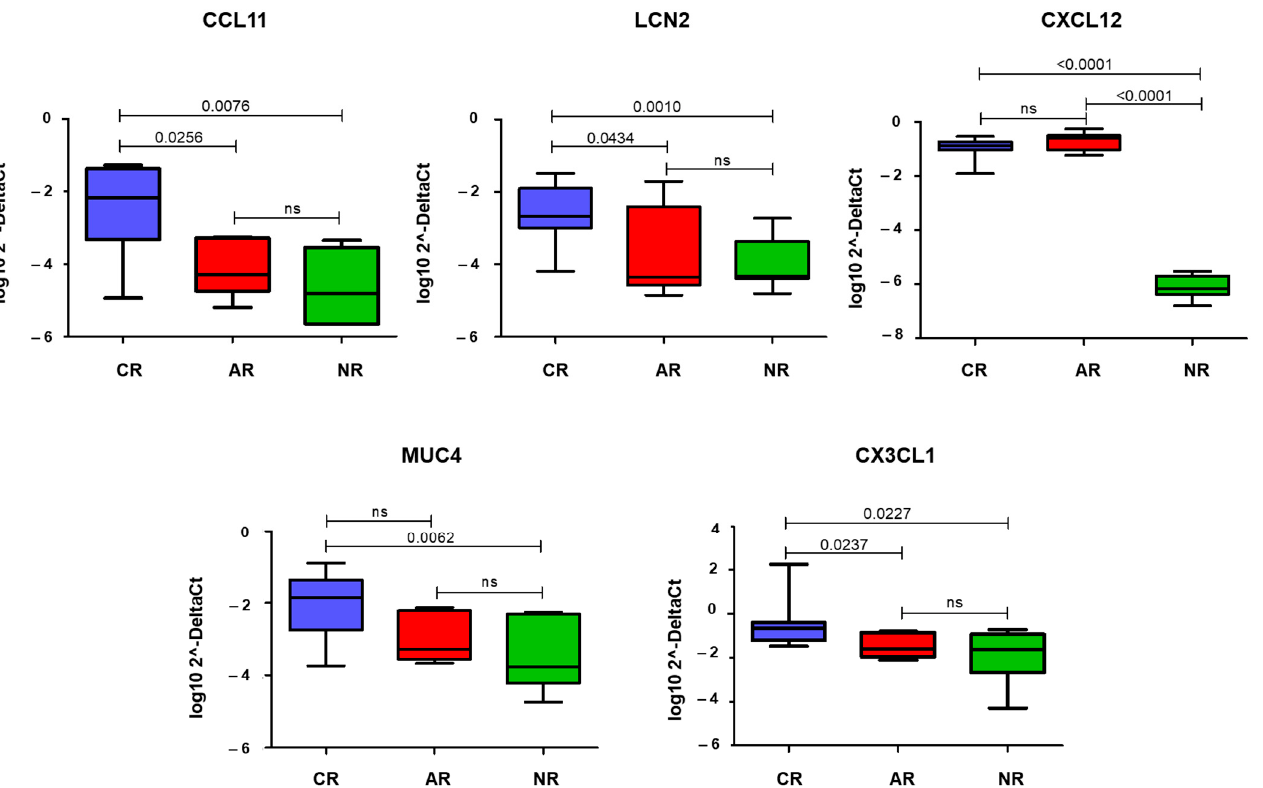
Figure 3. Box-plot showing quantitative Real-Time PCR (qRT-PCR) data of the statistically significant genes in each group of samples. The y -axis is a log transformation of the 2 −Δ Ct values. Horizontal bars show statistical significance ( p < 0.05) among the comparisons (CR vs. AR, CR vs. NR, and AR vs. NR). CR: chronic rejection; AR: acute rejection; NR: no rejection; ns: not significant.